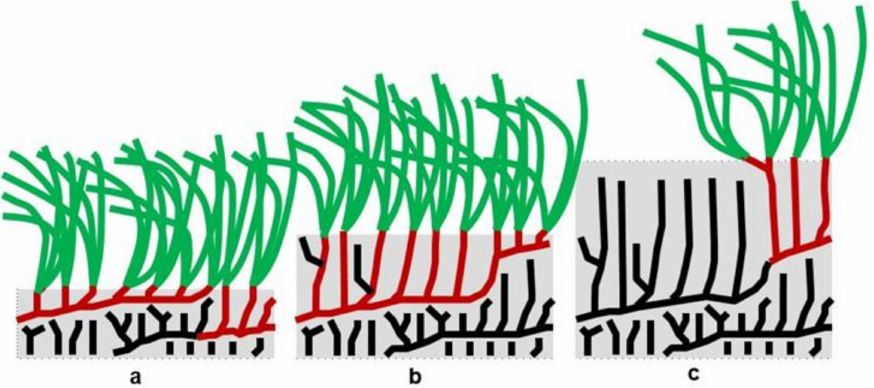
Figure 1. Formation of an autogenic dead matte patch within a Posidonia oceanica meadow. Orthotropic (vertical) rhizomes react to the trapping of sediment and their burial by vertical growth so that the sea bottom rises ( a – c ). Leaf shoots located at the tips of orthotropic rhizomes, that are too long, will die, which results in the formation of a patch of dead matte of natural origin. On the right side of ( c ), a new plagiotropic (horizontal) rhizome is starting to recolonize the dead matte patch. Green: leaves; red: live rhizomes; black: dead rhizomes. From Boudouresque et al. [11],